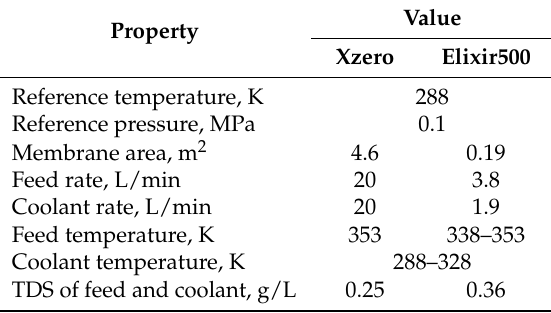
Table 1. The experimental and reference state conditions for the two types of AGMD systems